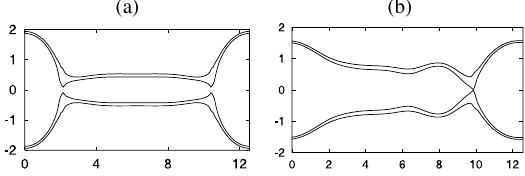
Fig. 3 Periodic capsule profiles for di ff erent ¯ u 1 and ¯ u 2 when ρ = 0 . 9, σ = 1 and ¯ b = 0 . 1; (a) ¯ u = ¯ u = 0 at t = 20 . 18 and (b)¯ u 1 2